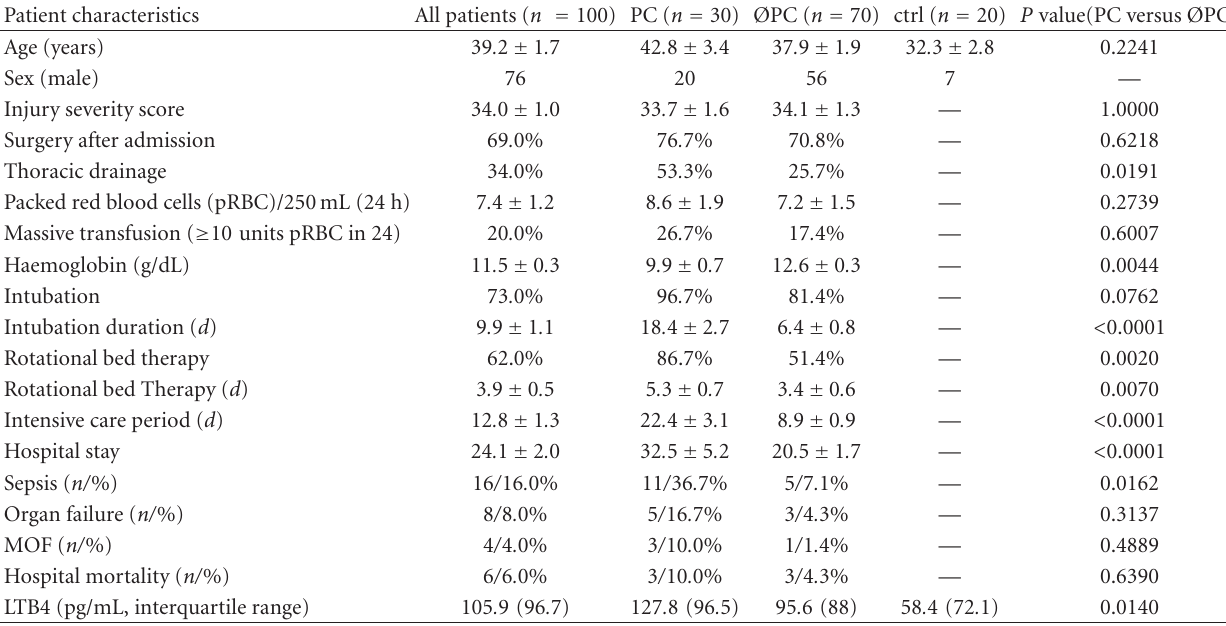
Table 1: Summary of patient characteristics and physiologic parameters in the investigated groups (ØPC: no pulmonary complications, PC: pulmonary complications and ctrl, data are presented as mean ± SEM unless otherwise stated).